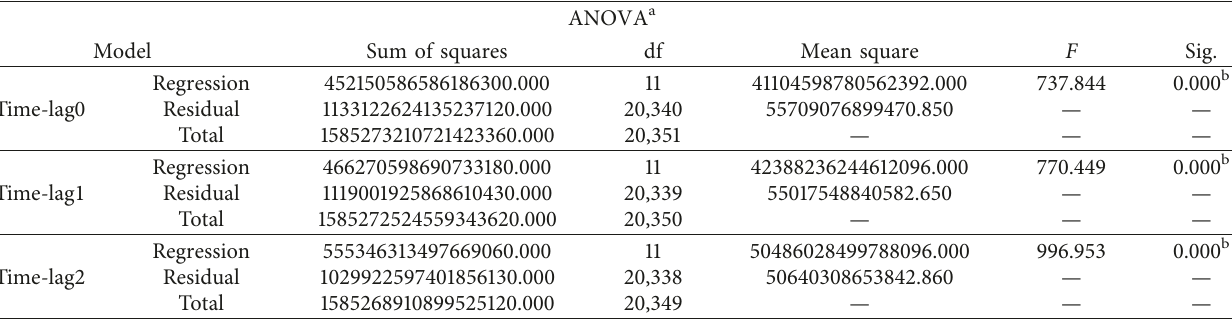
Table 4: ANOVA for a DOE small building depending on